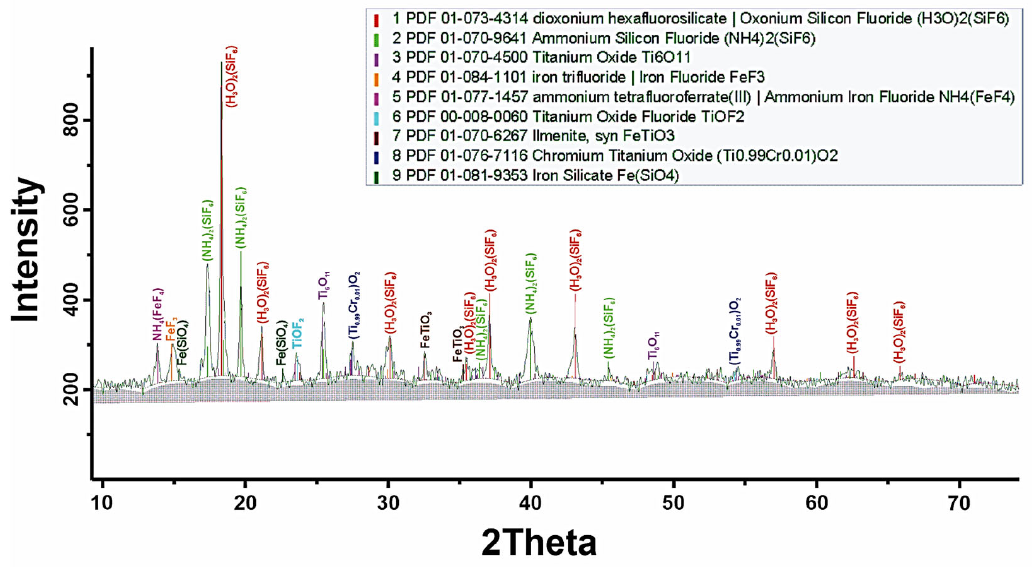
Figure 5. A diffractogram of the residue from fluorination of electrosmelting dust of ilmenite concentrate (2 h, 260 ◦ C, dust:NH 4 HF 2 = 1:0.9).